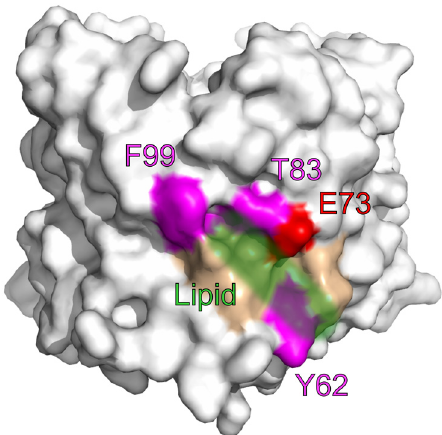
Figure 2. Proposed lipid binding pocket. Using a photo-affinity approach, a binding pocket around E73 (red) for cholesterol and allogenanolone was proposed by Cheng et al. [14]. Residues Y62, T83, F99 (magenta) and E73 (red) were photo labeled by sterol-based photolabeling reagents and labeling was competitively inhibited by cholesterol and allopregnanolone (lipid, green).